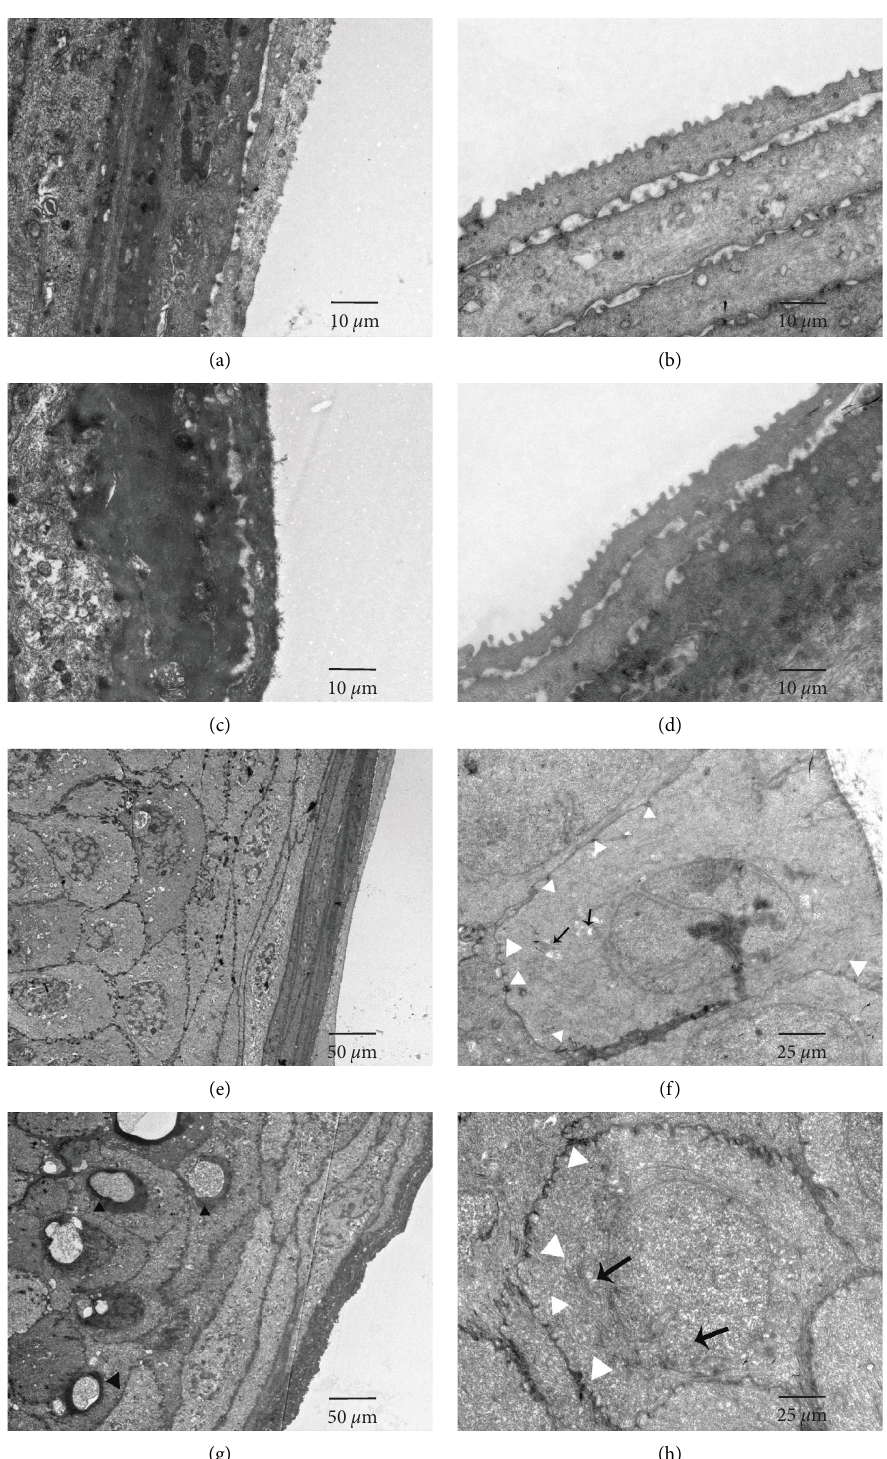
Figure 3: TEM in the cornea of rats. In the control group (a, b, e), TEM showed that the corneal fat epithelial cells were arranged in order. By contrast, decreased microvillus (d, g) and disordered stromal layer were observed (c, d) in the blue light group. Furthermore, vacuoles were found in the basal nuclei (g, black arrow head) compared to the unexposed group (e). Fewer desmosomes between adjacent cells were recorded after 4weeks of blue light exposure (h, white arrow head) with mitochondria swollen, vacuolated, and cristae disappeared (h, black arrow) compared with the control group (f). Scales of magnifcation: (a–d): 4000x. (e, g): 700x. (f, h):